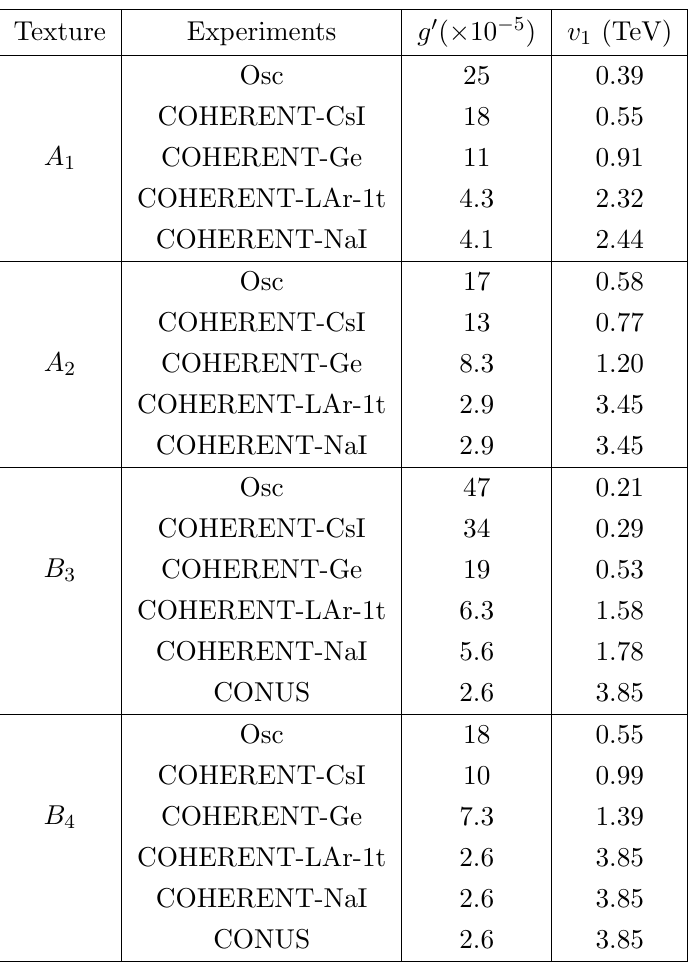
Table 6 . Set of representative values for the coupling constant g 0 and for the symmetry breaking scale v 1 have been provided for di(cid:11)erent detectors and experimental limits as shown in (cid:12)gure 3. Here we (cid:12)x M Z 0 = 100 MeV and v 2 = 1